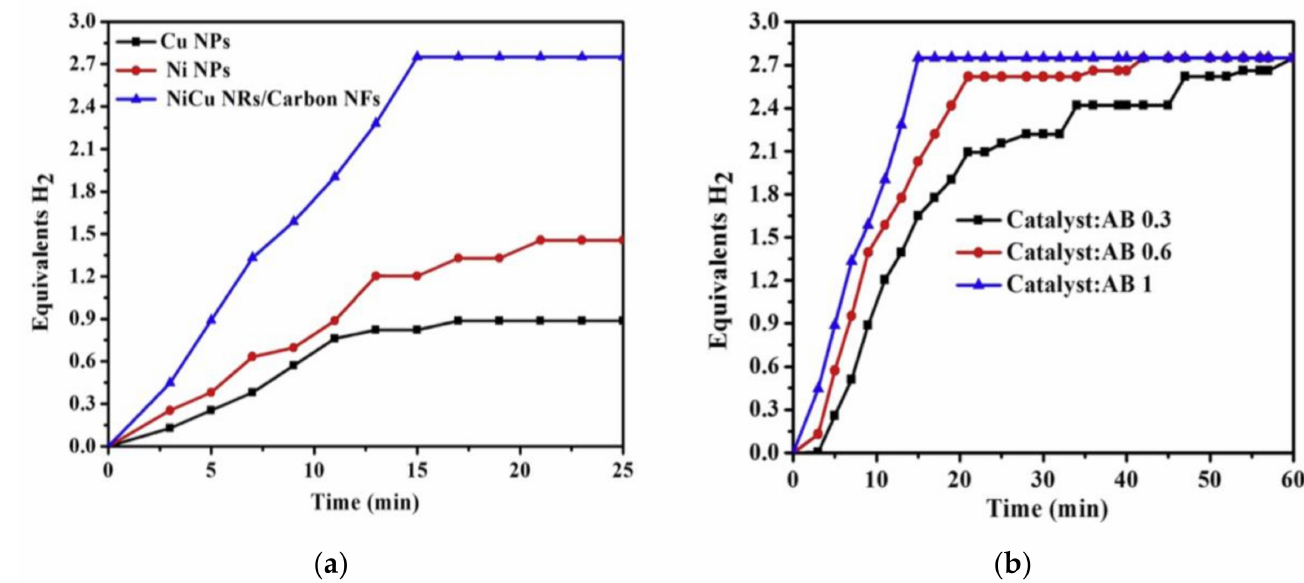
Figure 7. ( a ) Amount of generated H 2 using Cu NPs, Ni NPs, and electrospun NiCu NRs/C NFs; ( b ) Influence of the ratio of (NiCu NRs/C NFs catalyst to AB) on H 2 release. Reprinted from reference [54] with permission from